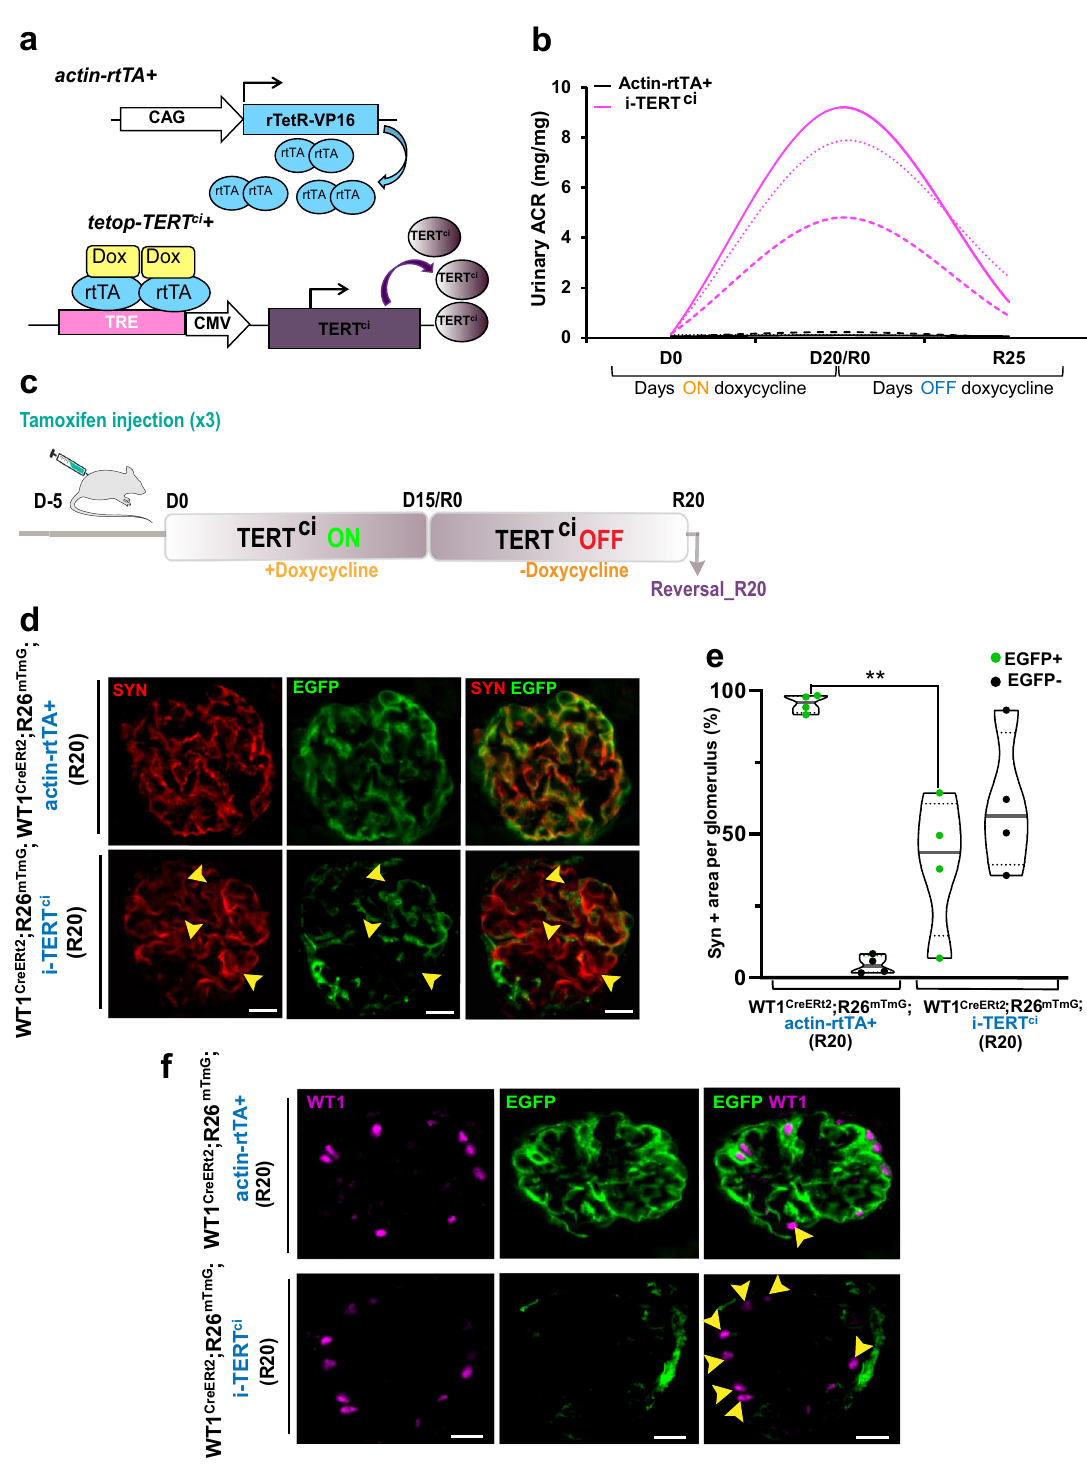
of proteinuria remission (Supplementary Fig. 11). Examination of EdU distribution within whole kidney sections of control mice revealed a basal level of cell proliferation within the kidney tubules (Fig. 4b, c). This result suggests that tubular epithelia undergo homeostatic turnover in steady-state conditions. Assess- ment of EdU distribution in the whole kidney section following a TERT ci pulse revealed the speci fi c appearance of arrays of proliferative cells within cortical tubular segments in i-TERT ci